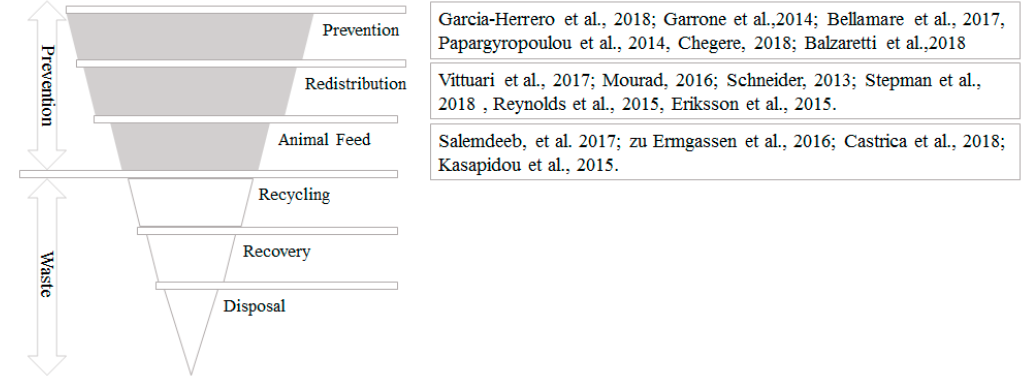
Figure 1. Food waste hierarchy and relevant literature.